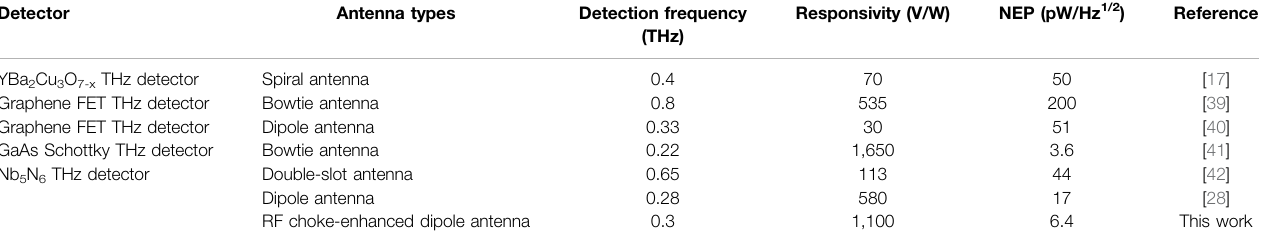
TABLE 1 | Performance comparison between the proposed Nb 5 N 6 THz detectors and other detectors.